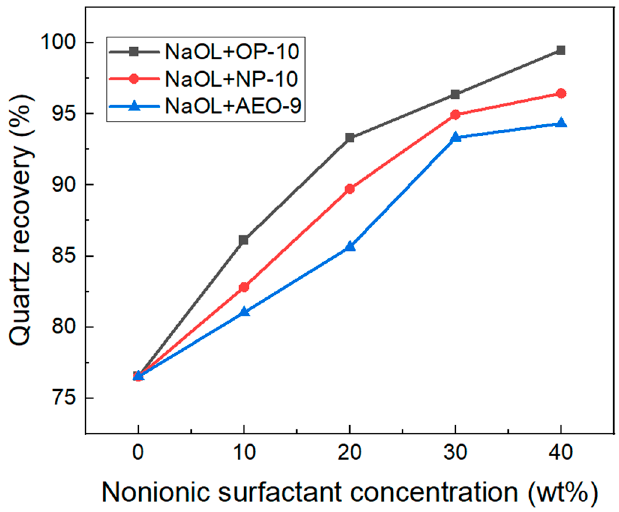
Figure 2. Dependence of quartz recovery using NaOL in synergy with alcohol ethoxylates (OP ‐ 10, NP ‐ 10 and AEO ‐ 9).